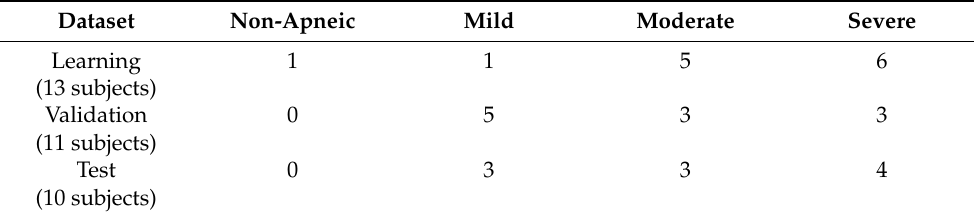
Table 1. Dataset compositions in terms of apnoea severity, based on ground-truth RDI :